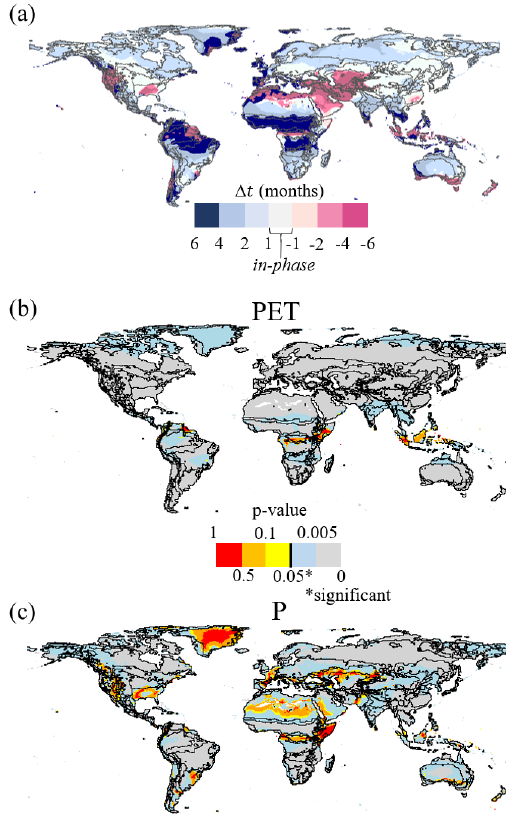
Figure 1. Global spatial distributions of (cid:49)t (a) and of performance of monthly P (b) and PET (c) sine fits represented by p